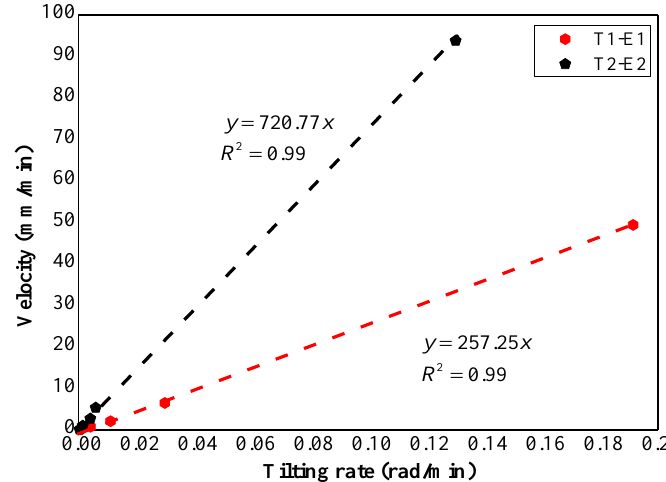
Figure 16. Tilting rate with unit rad/mm against velocity in Model Test 1.